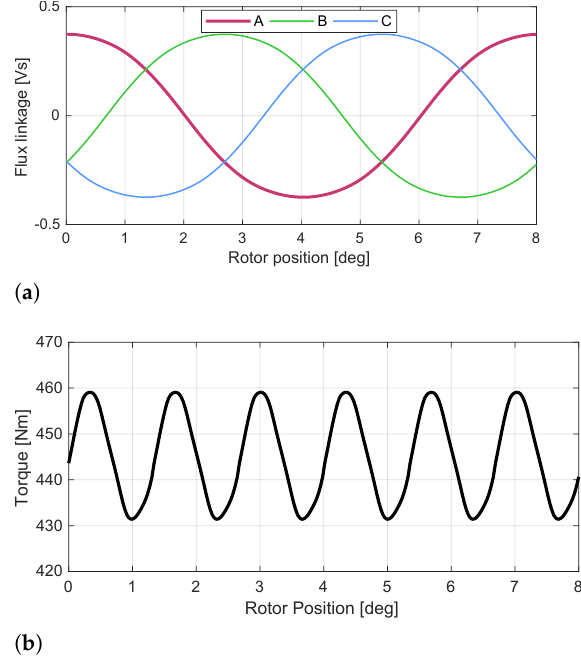
Figure 8. Analysis of the Spoke motor. ( a ) Flux linkage, ( b )